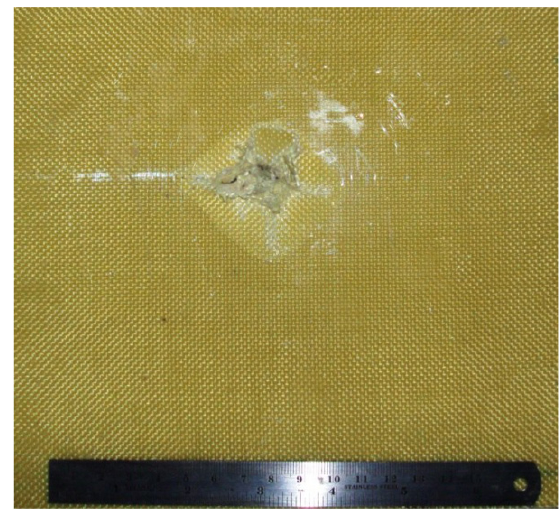
Figure 9. Damage on rear side of 19 layers 0/90 plate.